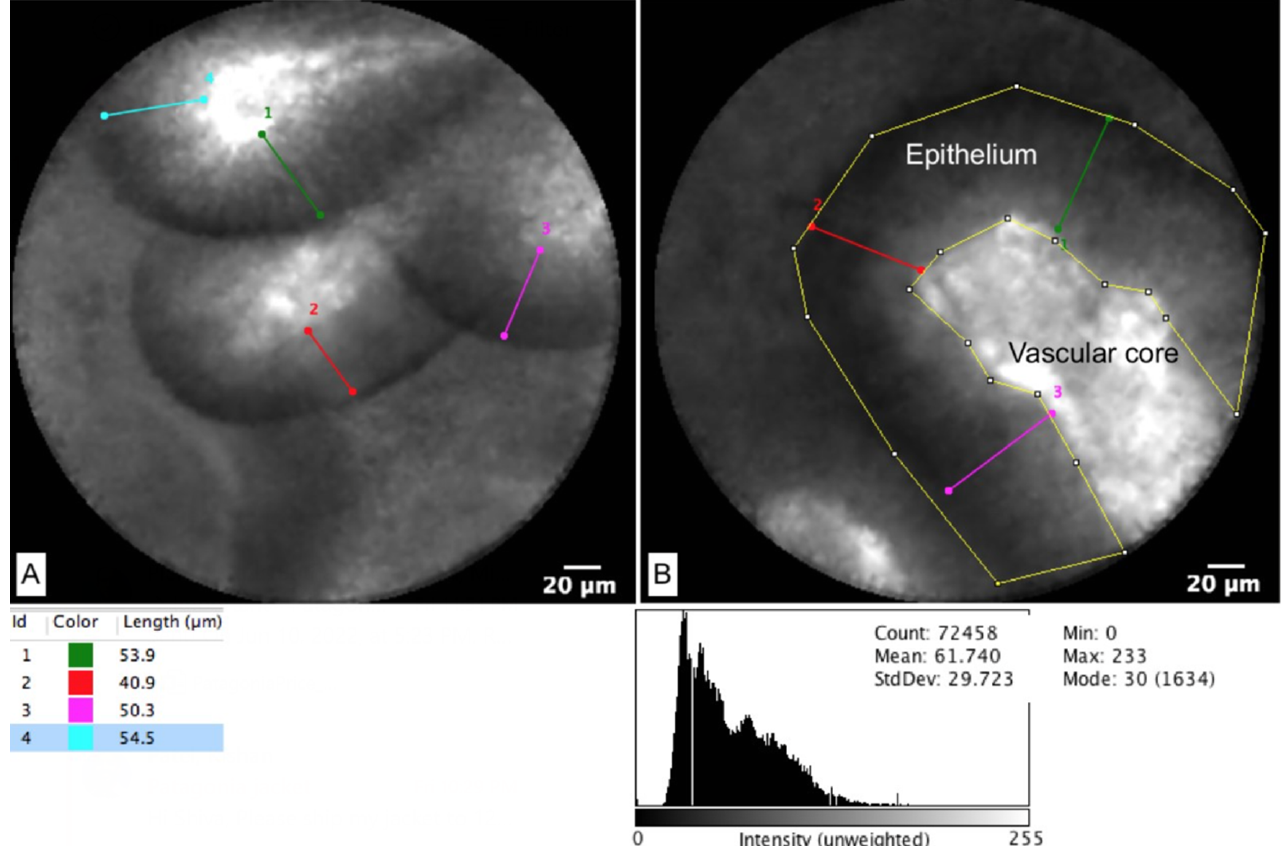
Figure 1. EUS-nCLE image of IPMN. A: Left panel : IPMN epithelium and vascular core. Each linear marking corresponds to a different epithelial thickness, as shown in the adjacent measurement. B: Right panel : IPMN epithelium and vascular core, with measurements of epithelial density as proxied by pixel intensity in image, with corresponding histogram of mean pixel intensity.